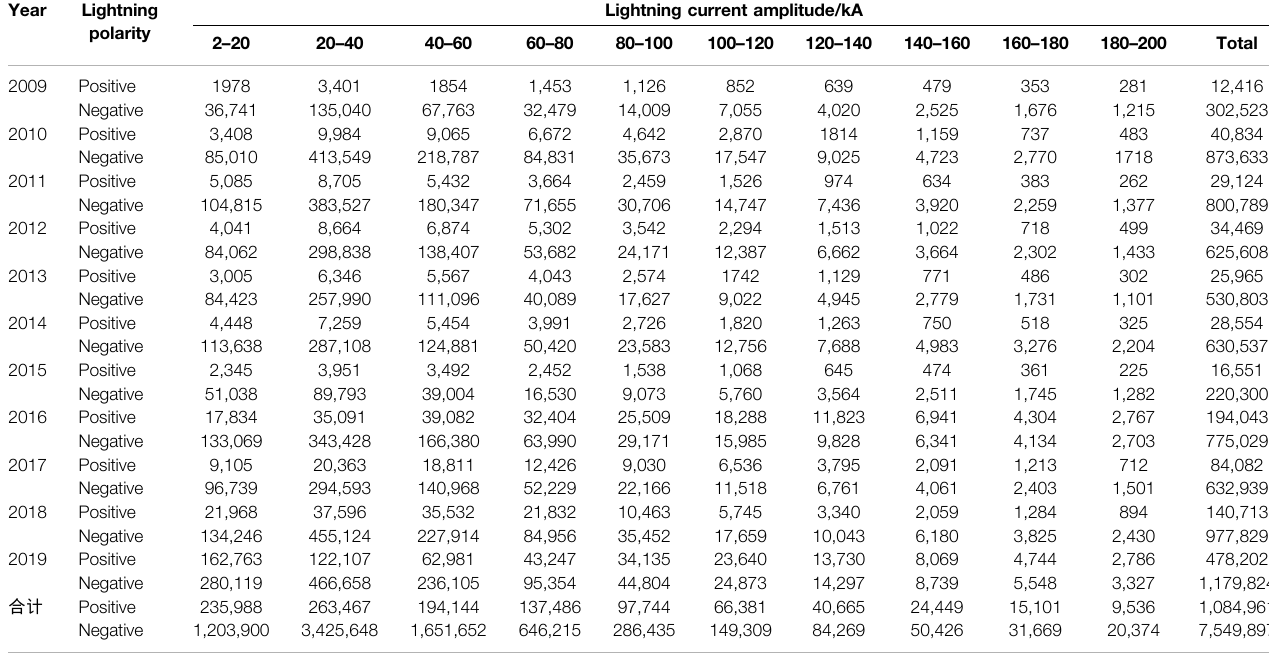
TABLE 1 | Lightning Current Amplitude Statistics from 2009 to